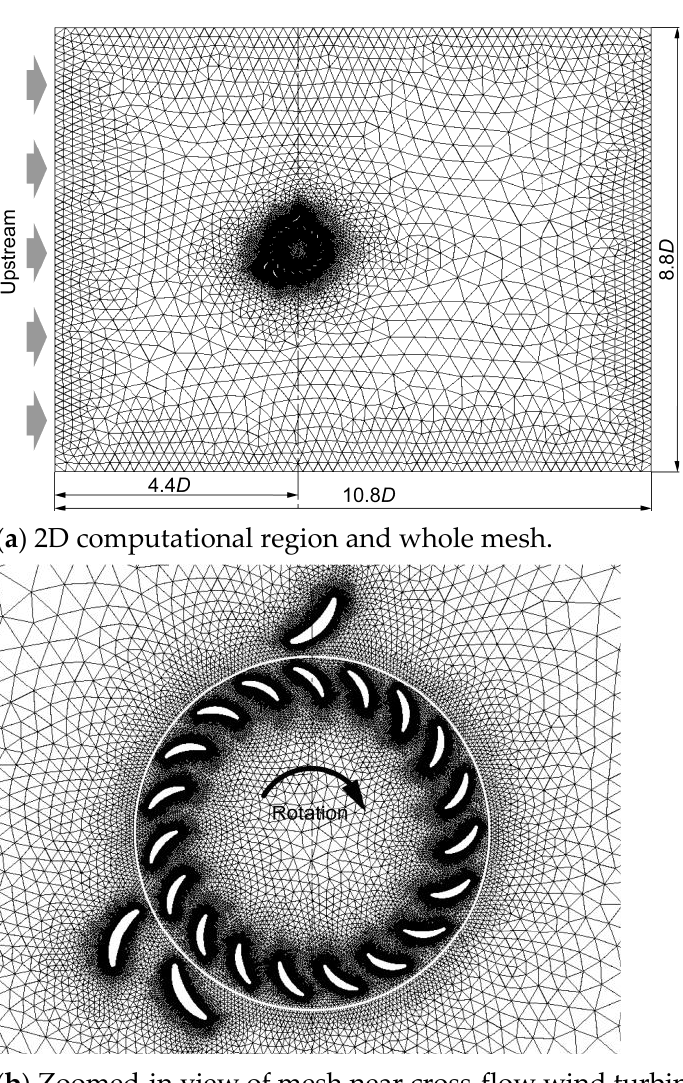
Figure 8. 2D computational region, whole mesh, and zoomed-in view of the mesh near the cross-flow wind turbine with three flow deflectors (in case of reference setting positions of flow deflectors).